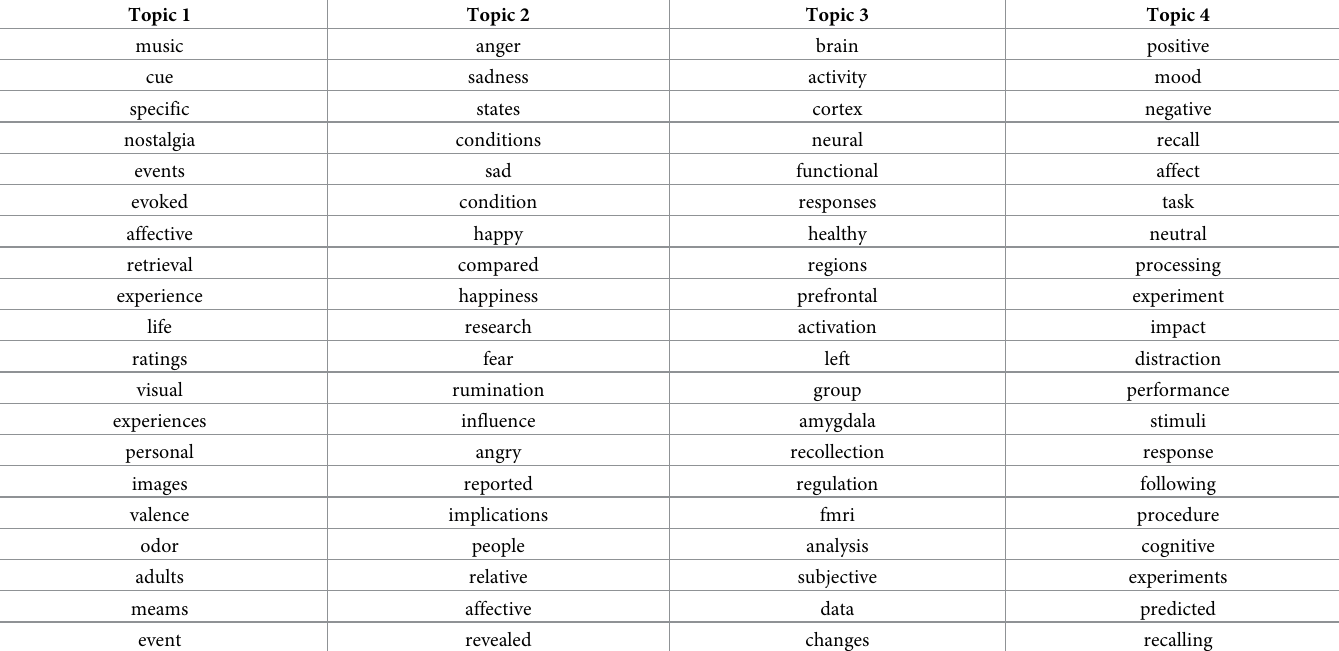
Table 1. Most frequent terms per